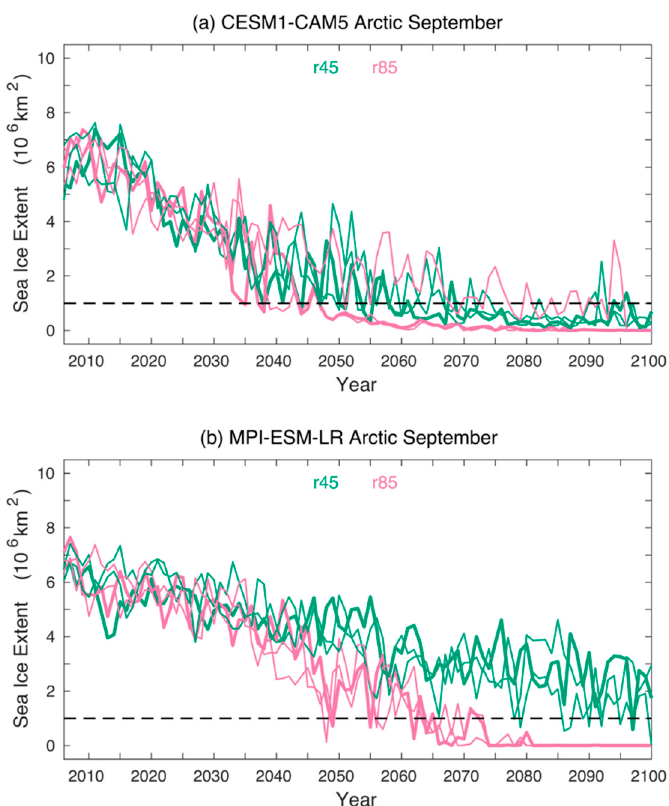
Figure 10. Time series of Arctic sea ice extents (10 6 km 2 ) in September of three ensemble members from ( a ) CESM1-CAM5 and ( b ) MPI-ESM-LR, color-coded for the RCP4.5 (r45 in green) and RCP8.5 (r85 in pink) scenarios. The thick solid lines denote the time series used in our analysis.